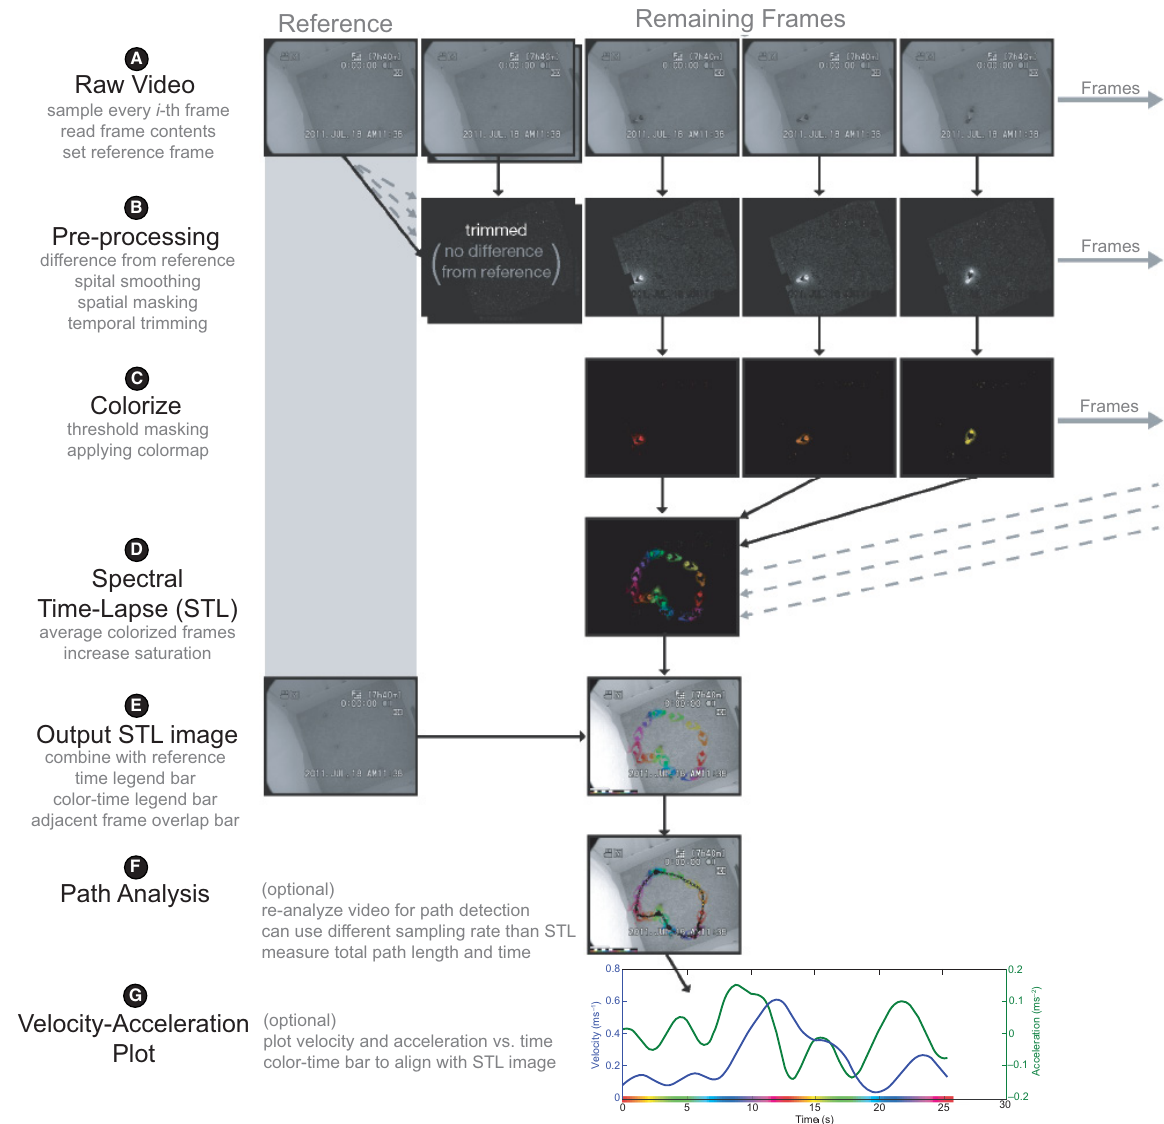
Figure 2. Illustration of the STL algorithm, the component stages, and examples of images at each stage. ( A ) Loading the raw video. ( B ) Pre-processing. ( C ) Colorizing the frames. ( D ) Creating the STL image. ( E ) Outputting the STL image. ( F ) Path analysis method. ( G ) Velocity-acceleration plot. corresponding to the target has been isolated. The color specific to the given frame is then applied, see Figure 2. D. Creating a spectral time-lapse (STL) image All colorized frames are averaged to produce a single frame that is essentially the STL image. To improve color visibility after averag- ing, the saturation of the averaged frame is amplified ( oversatCol ). E. Outputting the spectral time-lapse (STL) image To produce the final STL image, we overlay the averaged frame on the reference ( refFrame ). To further improve visibility of the colors, we increase the saturation of the reference ( oversatRef ).